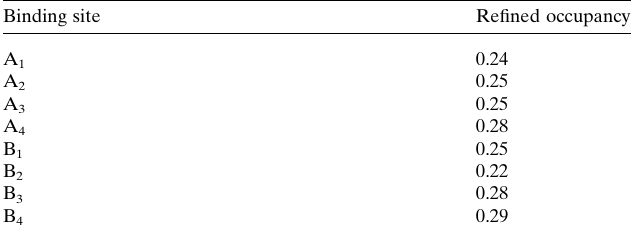
Table 1 Refined occupancy values for potassium ions within the selectivity filter. Sites A 1 to A 4 occur within the A chain while sites B 1 to B 4 occur within the B chain. Each potassium ion within the selectivity filter is shared between four unit cells and thus has a maximum occupancy value of 0.25. Occupancy values above 0.25 arise because of the correlation between the atomic displacement parameter and